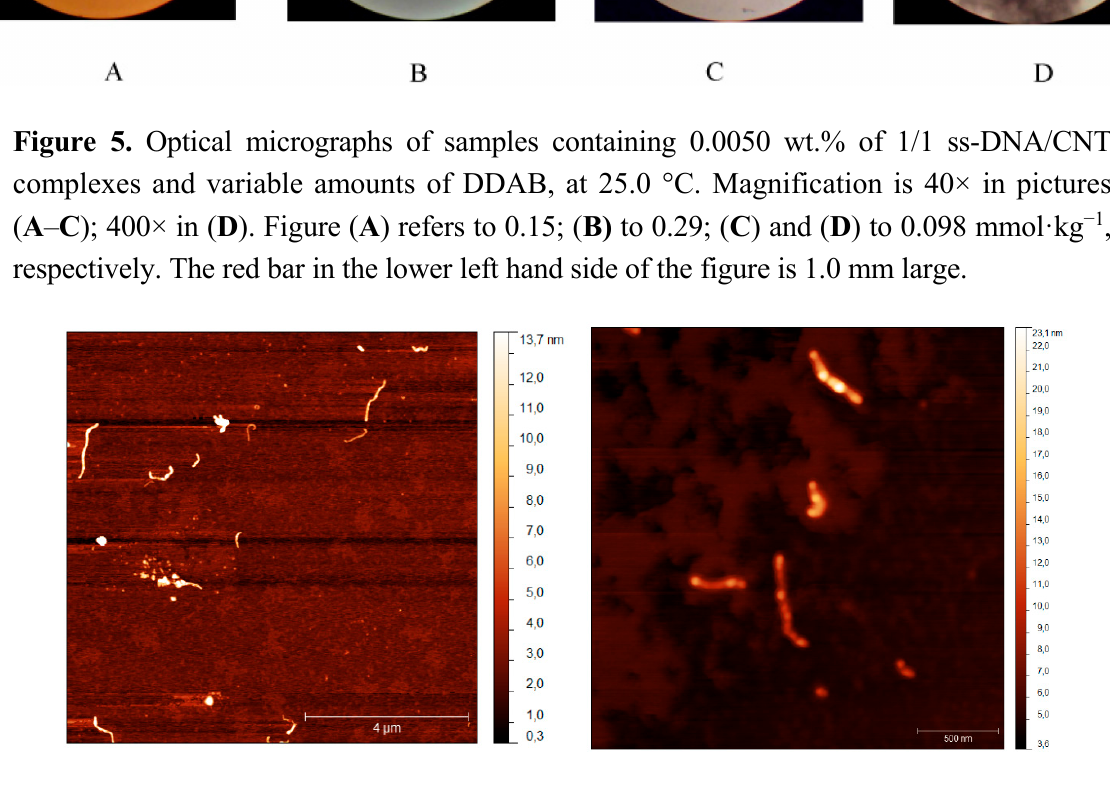
Figure 6. Atomic Force micrographs of samples containing 0.0050 wt.% of 1/1 ss-DNA/CNT complexes with no, left, and 0.4 mmol kg − 1 DDAB. The size of images is inferred by comparison with bars in the right bottom side of both